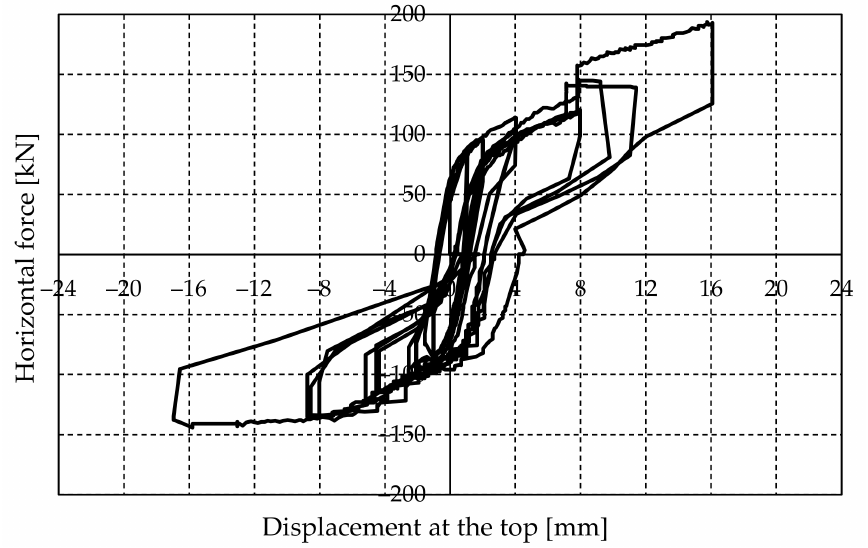
Figure 18. Force—displacement diagram for W4 (V = 230 kN, σ v = 0.4 N/mm 2